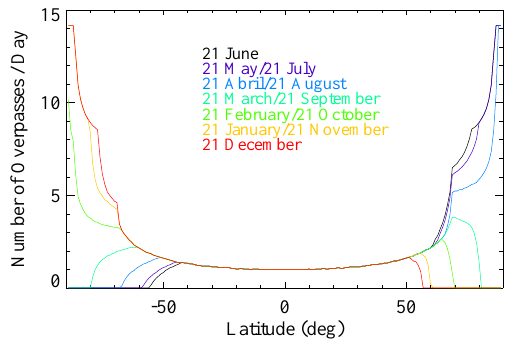
Fig. 5: Average number of overpasses per day by TROPOMI as a function of latitude and month. The calculations are for SZA < 80 ◦ , a sun-synchronous orbit and 13:30h Equatorial crossing time as appropriate for Sentinel-5 Precursor. Fig. 6: End-to-end simulations of SIF retrieval from TROPOMI in the 735–758 nm fitting window for a total of 153,600 TOA radiance spectra. Diamond symbols and error bars represent, respectively, the mean and standard deviation of all the retrievals for each vegetation type and range of atmospheric conditions and illumination/observation angles.